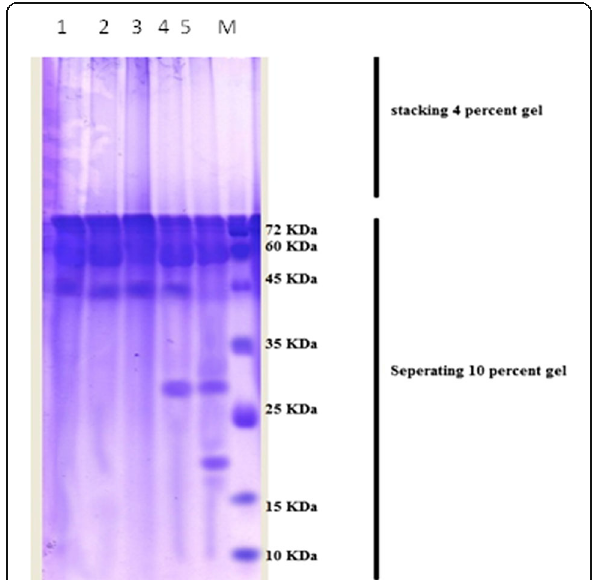
Fig. 4 SDS-PAGE profile of date palm callus treated with at different concentrations. M: Protein molecular marker; 1: control treatment; 2: Al at 50 mg.l -1 ; 3: Al at 100 mg.l -1 ; 4: Al at 150 mg.l -1 ; 5: Al at 200 mg.l -1